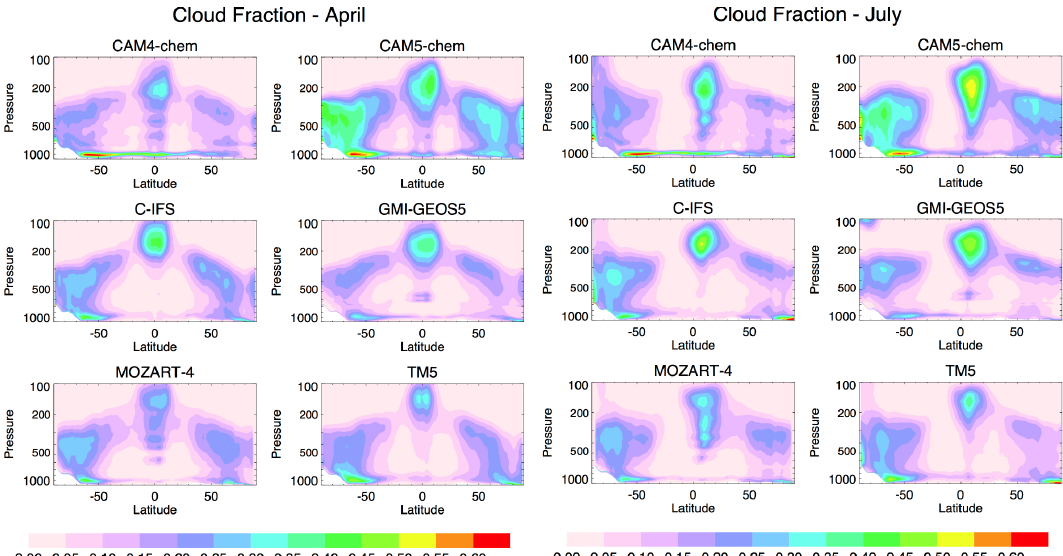
Figure 3. Zonal average of cloud fraction for April (left) and July (right).